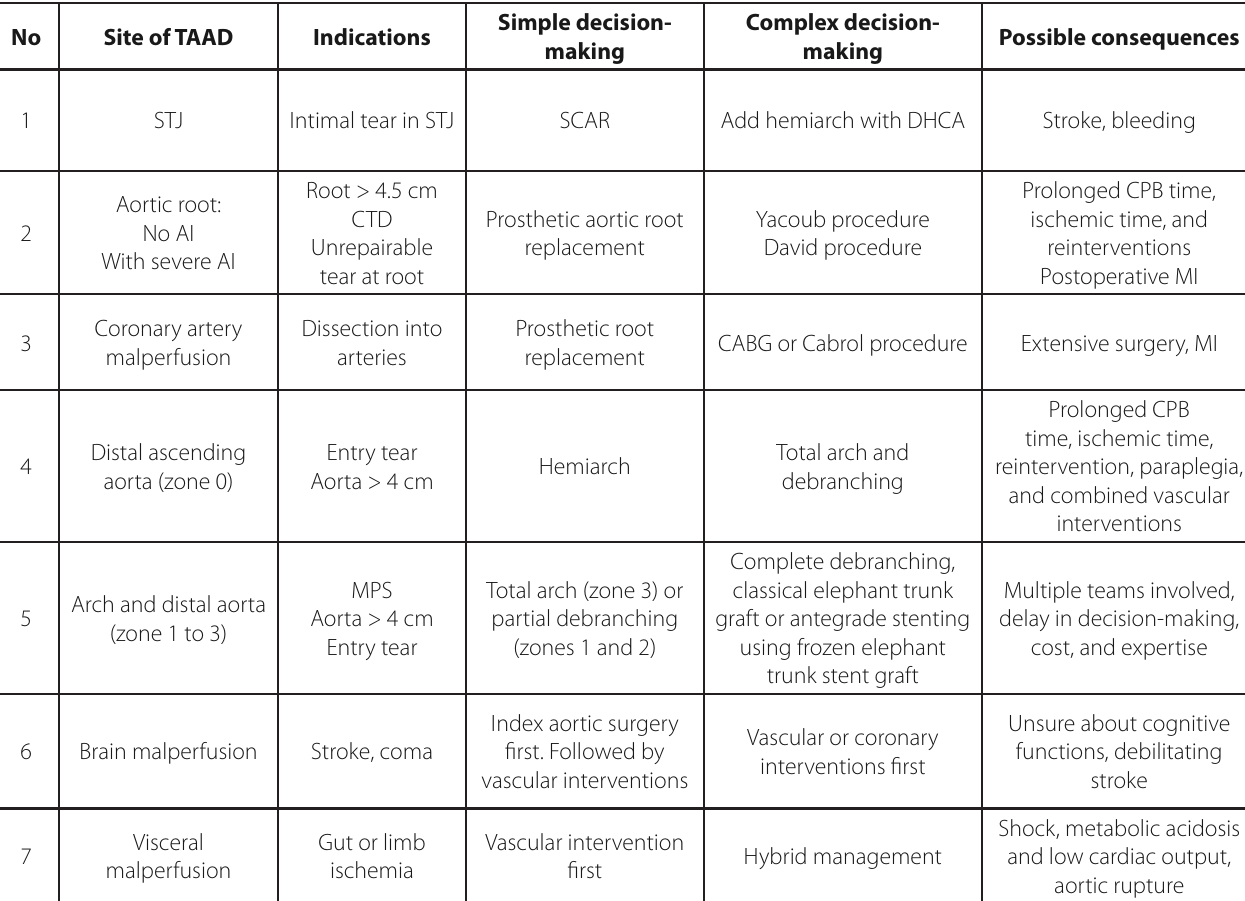
Table 1. Management